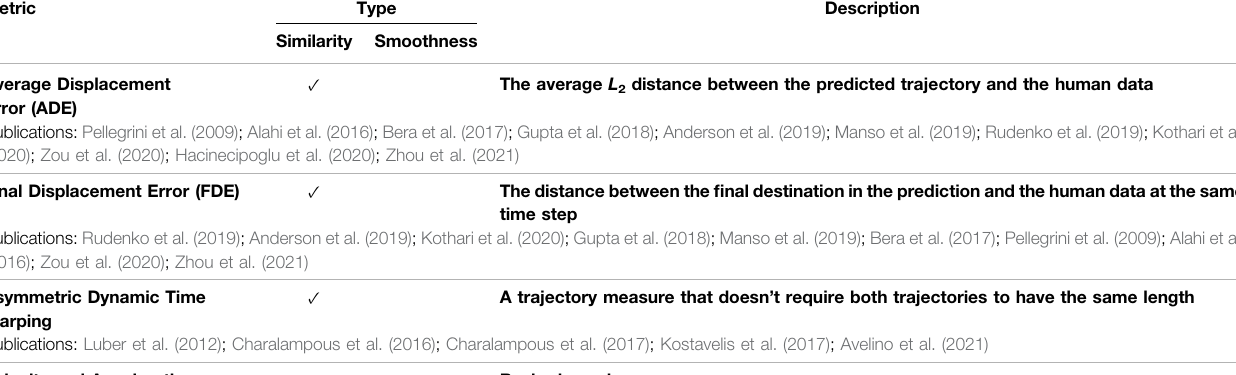
TABLE 5 | Evaluation metrics for